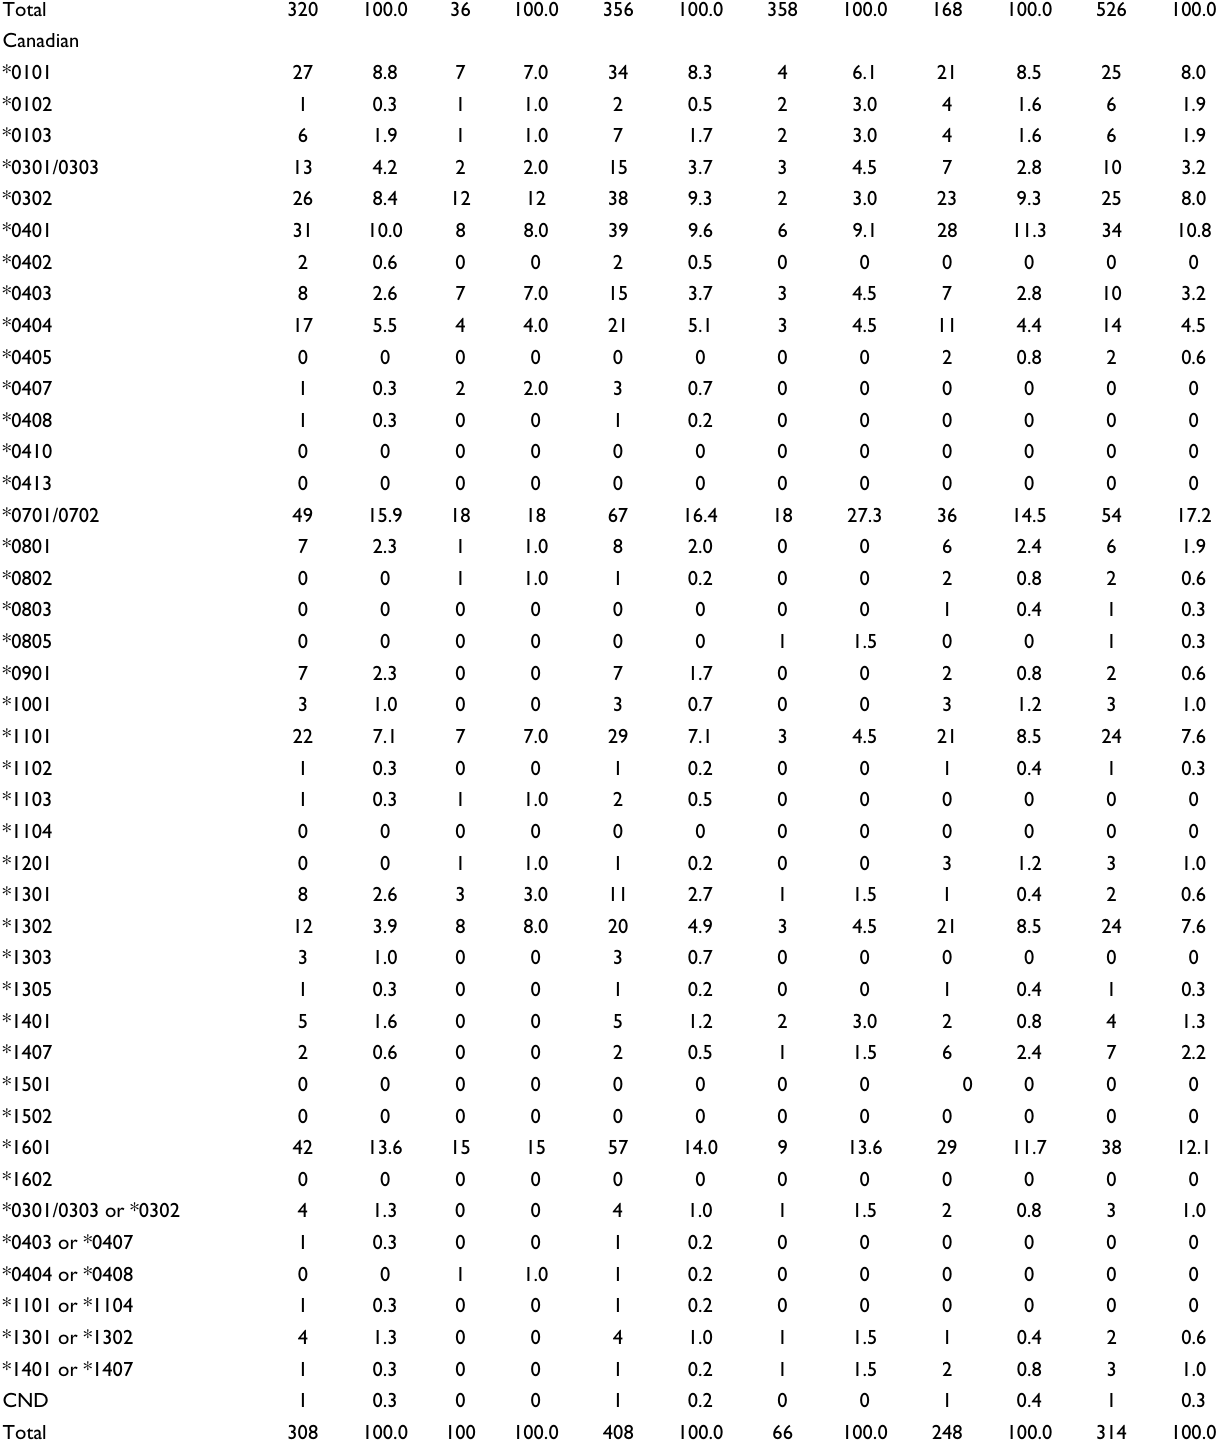
Table 3: HLA-DRB1 allele frequencies in AAA cases and controls